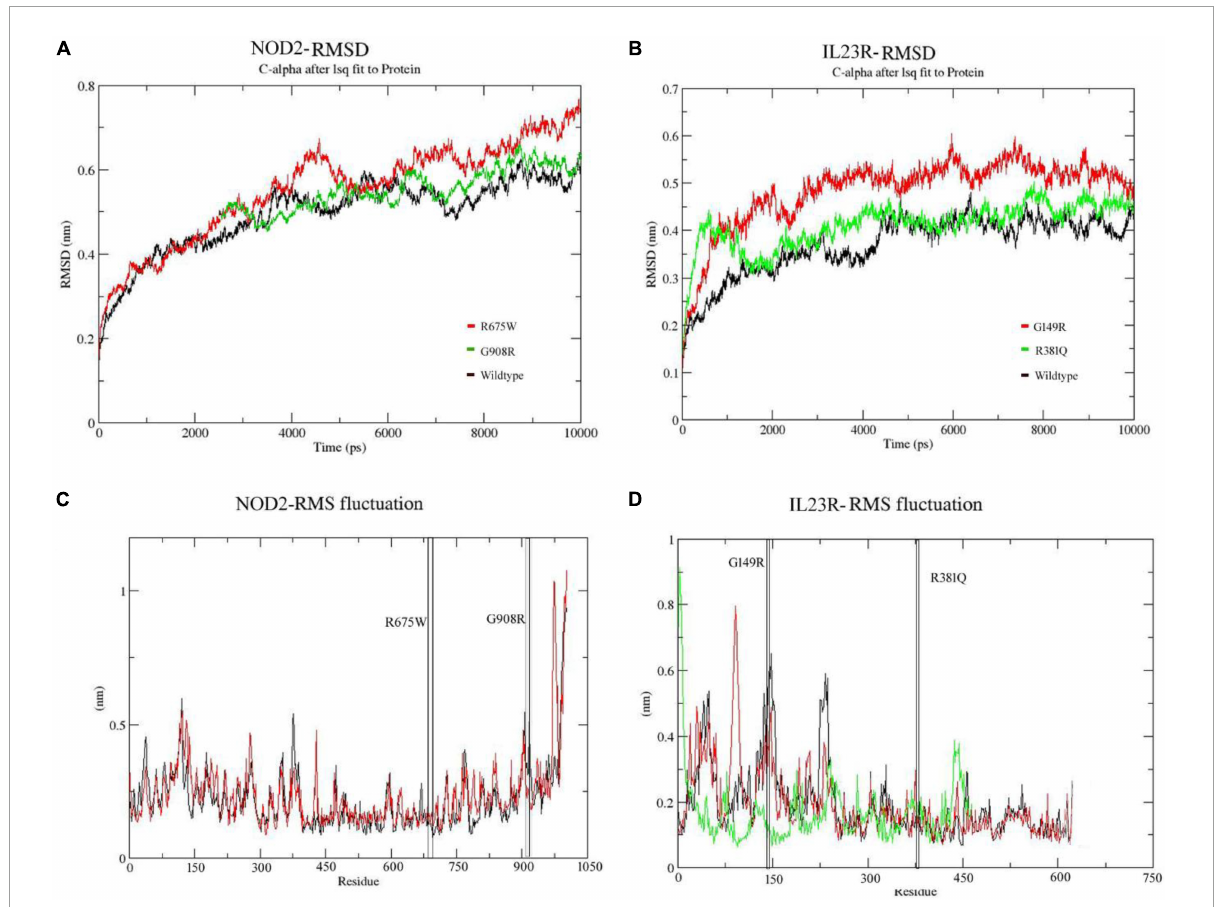
FIGURE4 (A,B) Molecular dynamics RMSD of NOD2 and IL23R at 100ns. (C,D) MD simulation RMSF of NOD2 and IL23R at 100